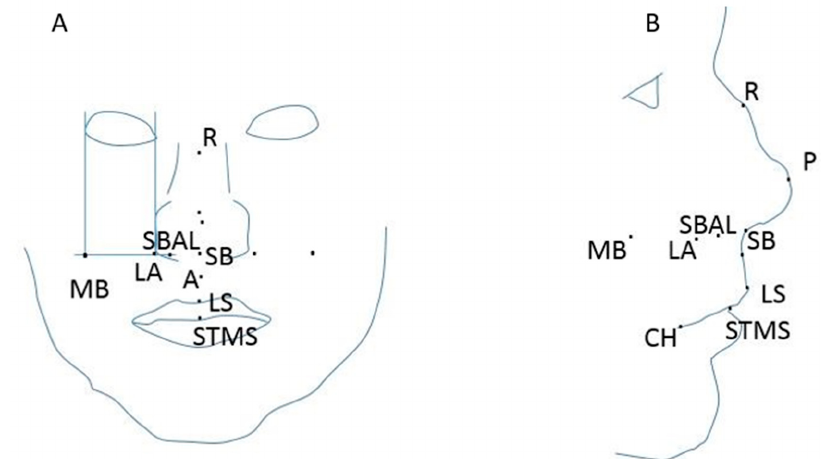
Figure 4. Points for measurement by Resnick et al. ( A ) Frontal view. The two points derived for this study are shown: lateral ala point (LA), defined as the intersection of lines tangent to endocanthion (EN) and subnasale (SBAL), and maxillary buttress (MB) point, and defined as the intersection of lines tangent to exocanthion (EX) and SBAL. (B) Lateral view showing all points [28].